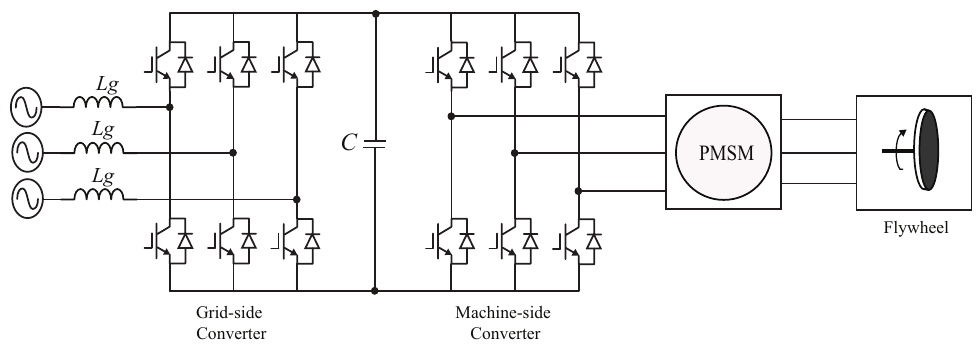
Figure 3. Power Converters in a FESS.